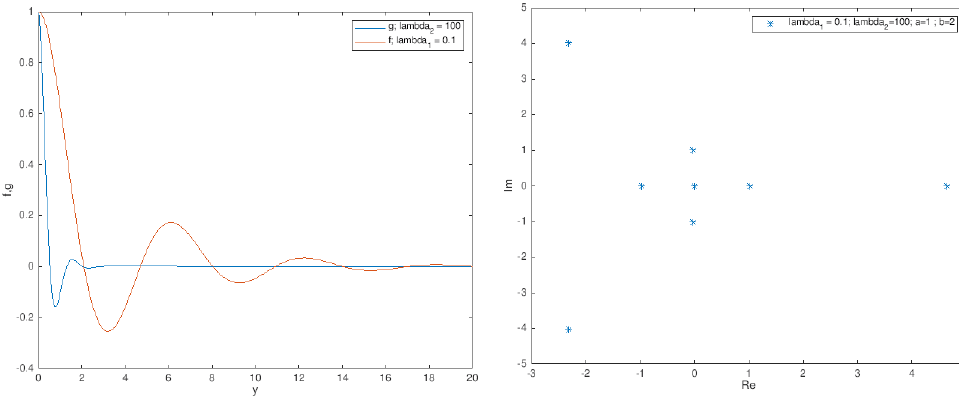
Figure 16. TW evolution and Homotopy graph for a = 1, b = 2, λ 1 = 0.1 and λ 2 = 100.